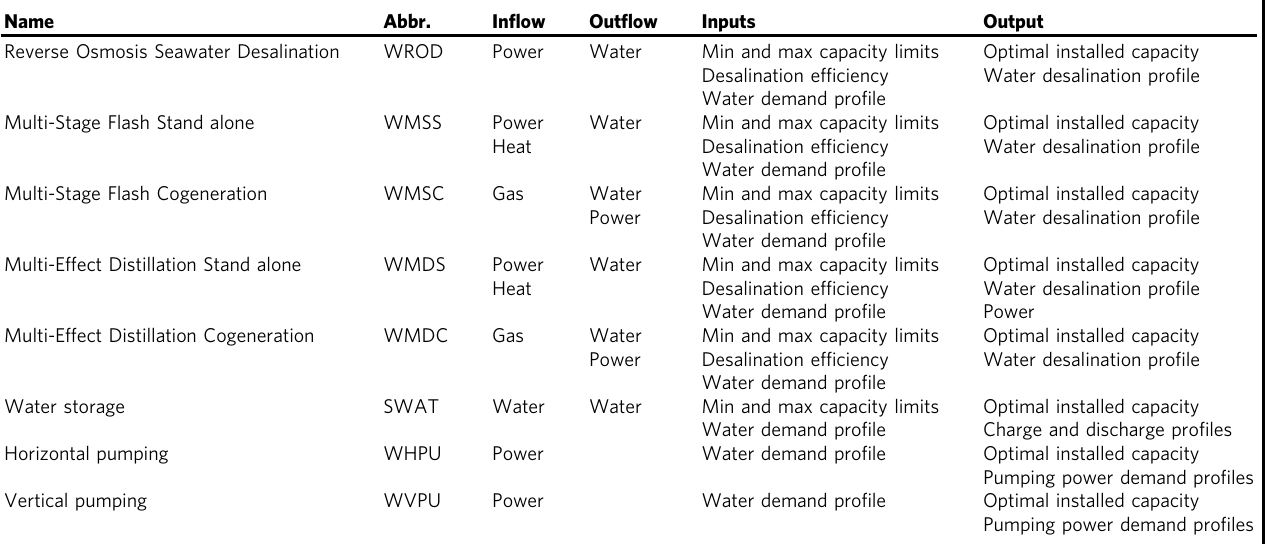
Table 11 Water desalination and supply